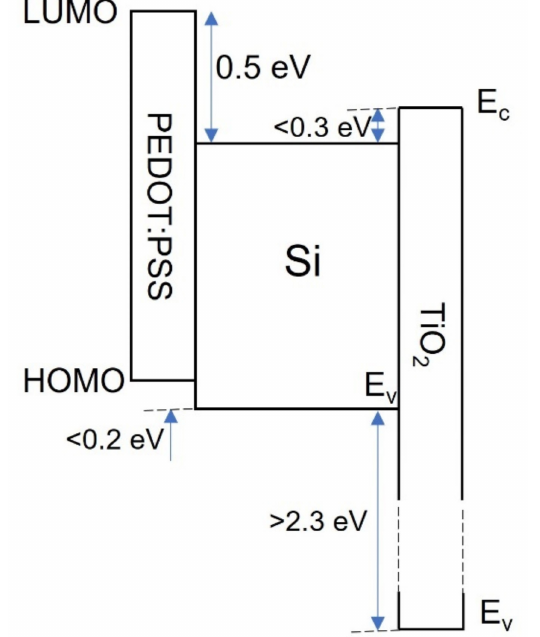
Figure 10. Schematic energy diagram of the PEDOT:PSS/Si/TiO 2 DHJ solar